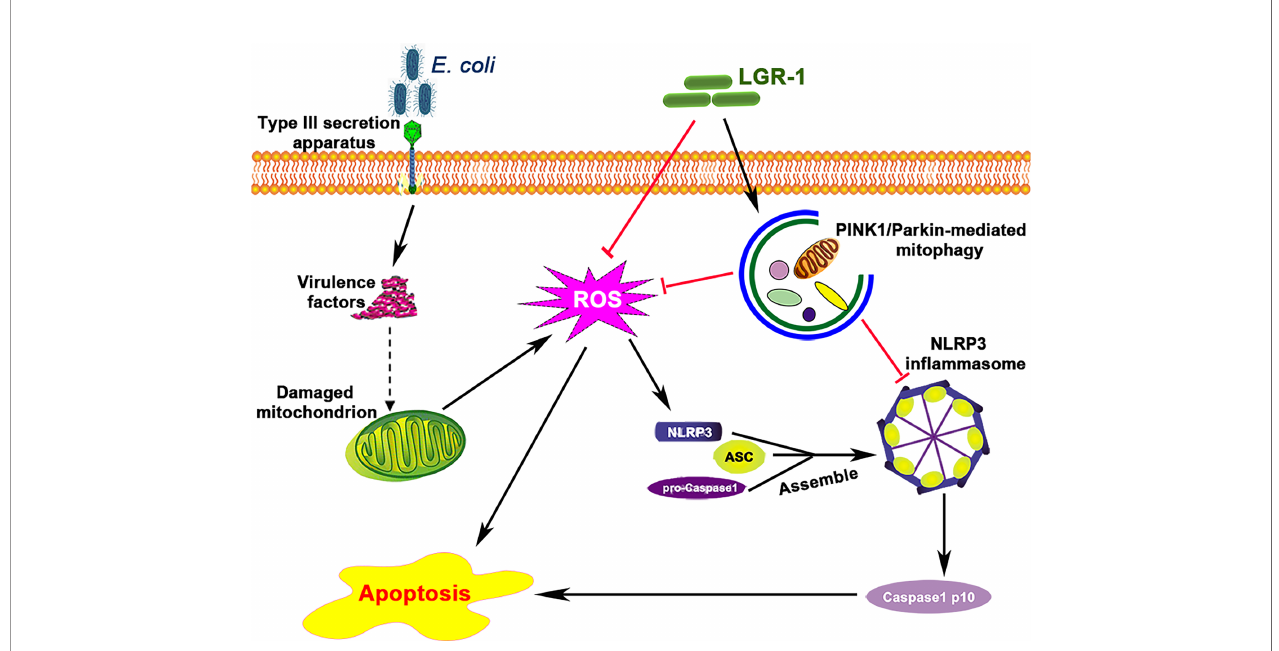
FIGURE 10 | Lactobacillus rhamnosus GR-1 prevents Escherichia coli -induced cell apoptosis through PINK1/Parkin-mediated mitophagy by inhibiting ROS production and NLRP3 in fl ammasome activation. E. coli secretes virulence factors via the type III secretion system and causes mitochondrial dysfunction. The damaged mitochondrion produces excessive reactive oxidative species (ROS), which induces NLRP3 in fl ammasome activation and subsequently causes apoptosis. LGR-1 has anti-ROS function and inhibits ROS production. LGR-1 pretreatment induces mitophagy that eliminates ROS and inhibits NLRP3 in fl ammasome activation. The solid arrows indicate demonstrated effects, the dashed arrow indicates the potential effects, and the red lines indicate negative